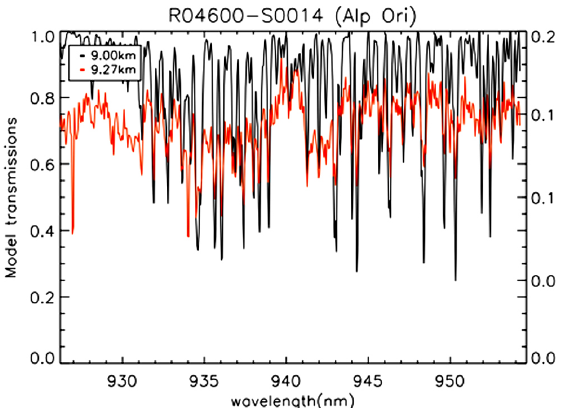
Fig. 16. GOMOS transmission obtained with the star Alpha Orionis (S0014 is the GOMOS ID number) at a tangent altitude of 9.27km just below the tropopause (red curve, right scale), and the model transmission at 9km (black curve, left scale). There are features in the measured spectra that do not come from H 2 O absorption, but rather from an imperfect correction of the severe pixel-to-pixel- non-uniformity affecting the CCD of spectrometer B2 in the range 940nm. This was taken on ENVISAT orbit n ◦ 4600.